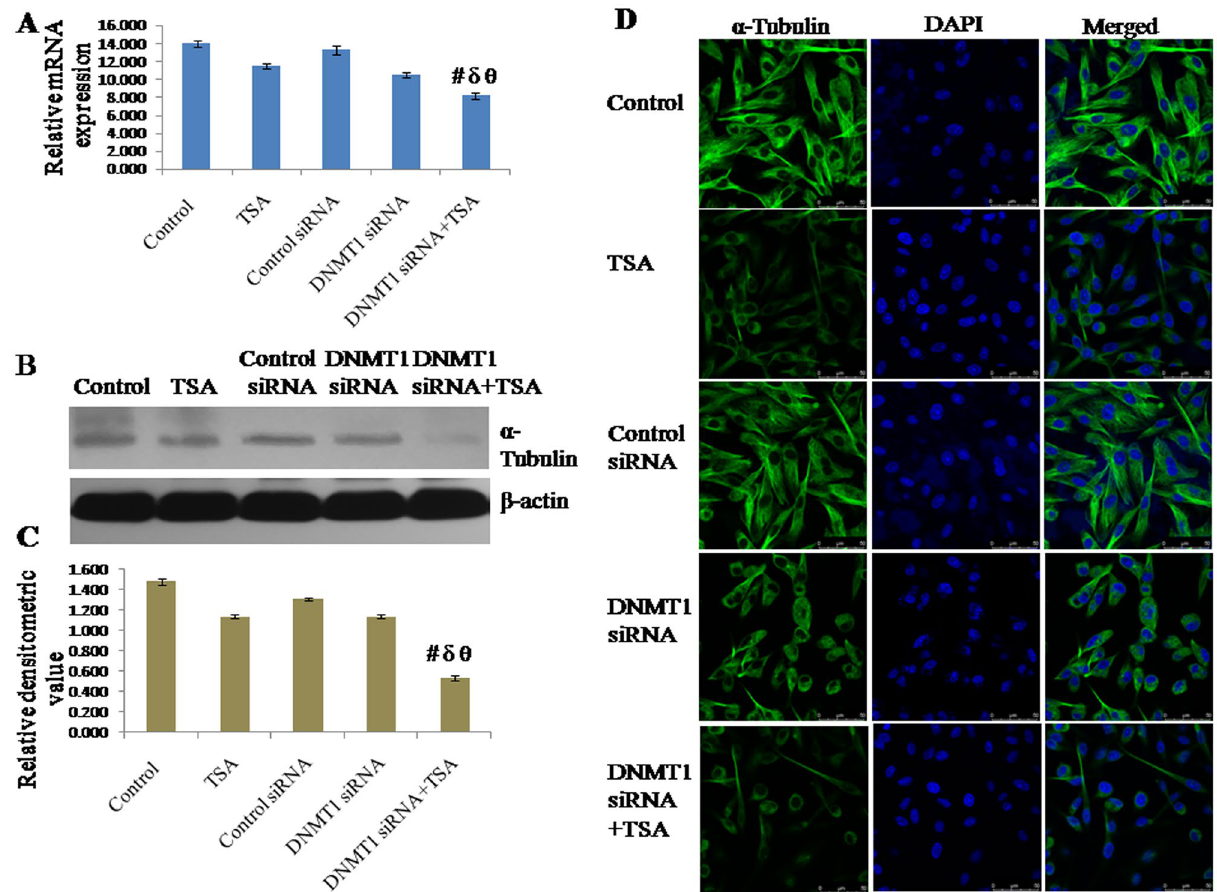
Figure 5. Expression of α-Tubulin analyzed by ( A ) qRT-PCR using GAPDH as internal control and expressed in terms of relative mRNA expression, ( B , C ) Western blotting using β-actin as internal control and expressed in terms of relative densitometric value, ( D ) immune fluorescent staining and confocal microscopy to observe cellular localization. The representative blots of replicates were presented here. The full-length original images (cropped) of representative blots were presented in the supplementary Fig. S6 of Supplementary information file. Data was represented as mean ± SEM., n = 3, p < 0.05. #, δ and θ represent; compared to control group, TSA treated group and DNMT1 siRNA transfected group